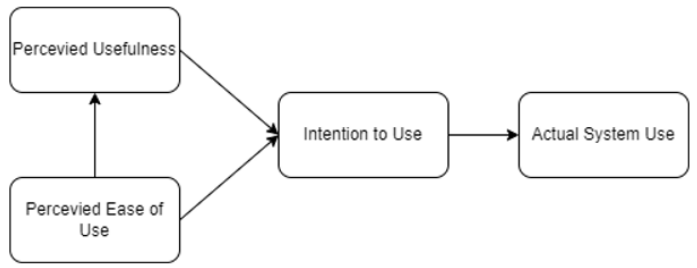
Figure 1. Technology acceptance model [20].